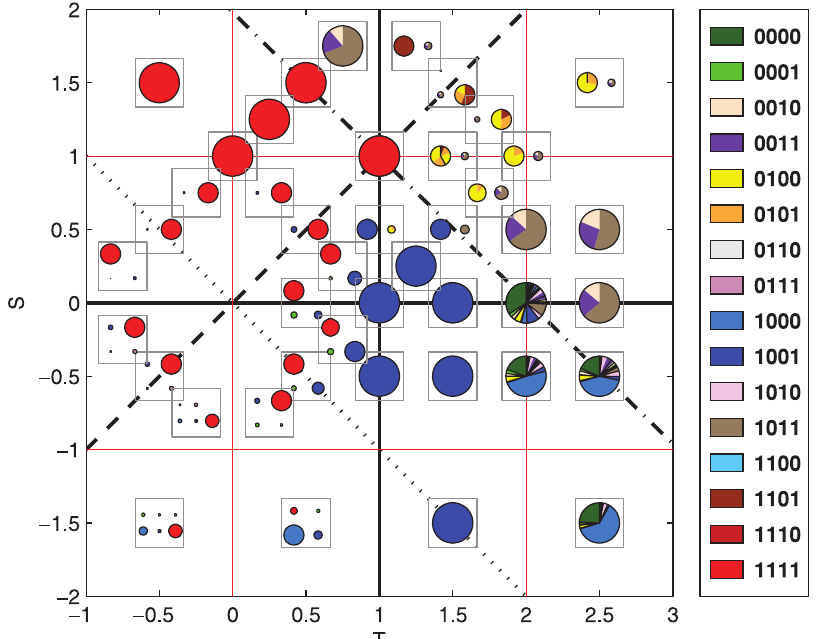
Figure 1. Composition of the recurrent sets for each studied game. The centers of the squares correspond to the pairs ( S , T ) that define those games. Each strategy is assigned a different color (color code in the separate column on the right). Within each square there may be one or more pie charts. Each of them represents a different recurrent set. The sizes of the pies are proportional to the average probabilities of reaching them from the transient states ( (cid:2) aa m ). Pie sectors separated with thick lines correspond to different nodes of the recurrent set. Their sizes are proportional to their probabilities in the stationary state (given by the components of the vectors s m ). If a sector is of one color it means that the node corresponds a pure strategy; if it is subdivided in smaller sectors with different colors it means that the node corresponds to a mixed strategy, the different colors representing the coexisting strategies. The sizes of these sub-sectors are proportional to their fraction within the mixed strategy.